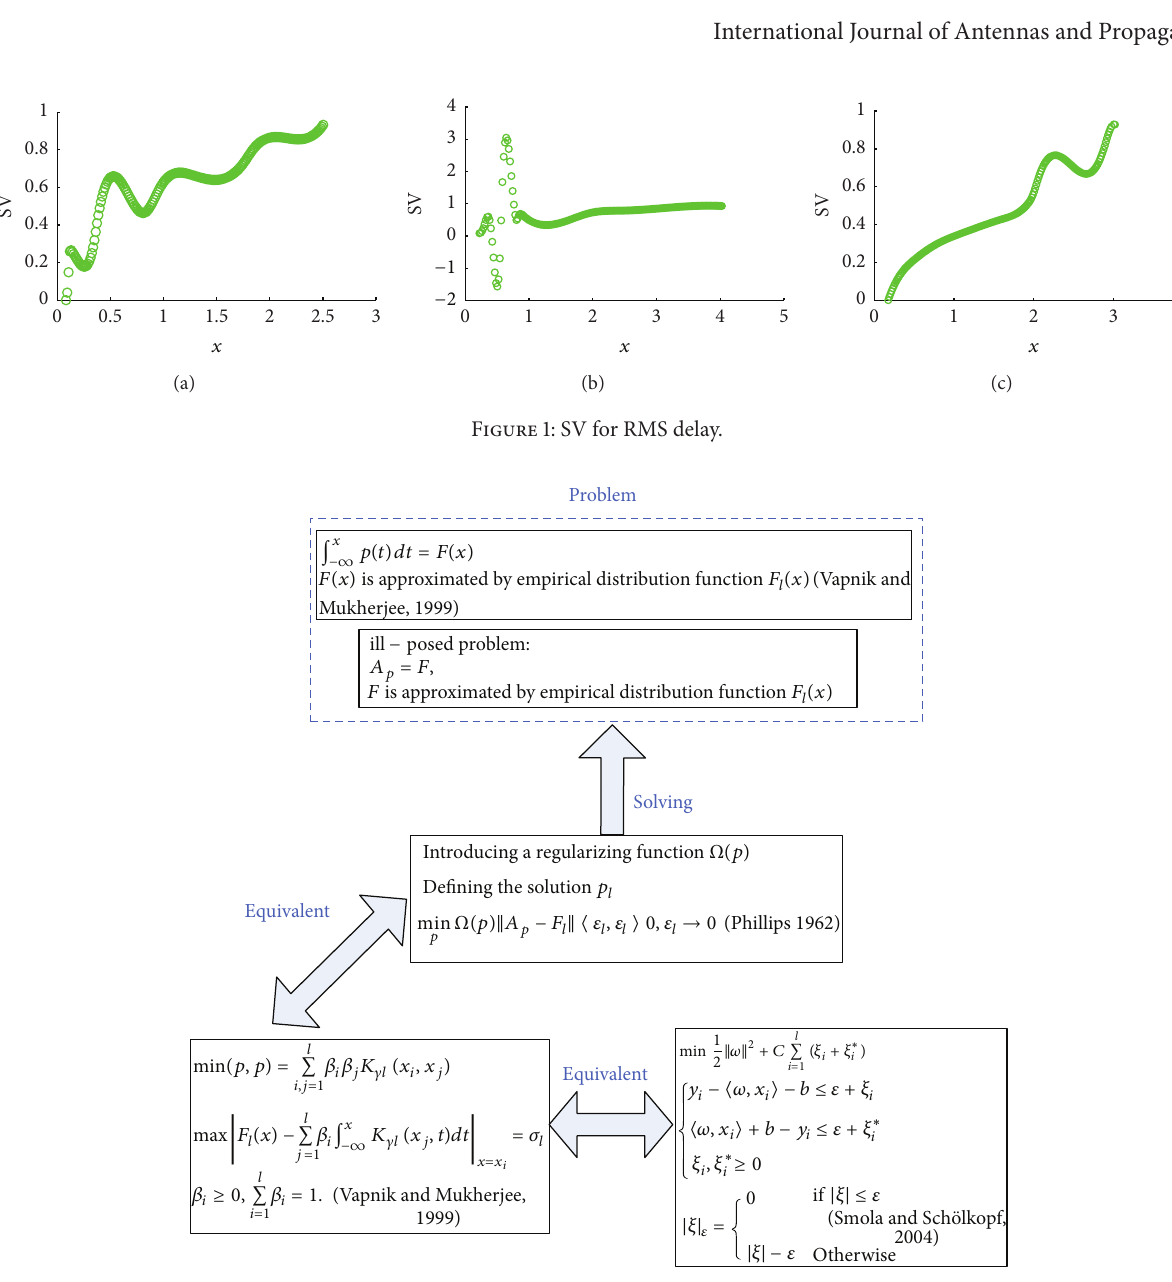
Figure 2: The algorithm for density estimation in BANs.